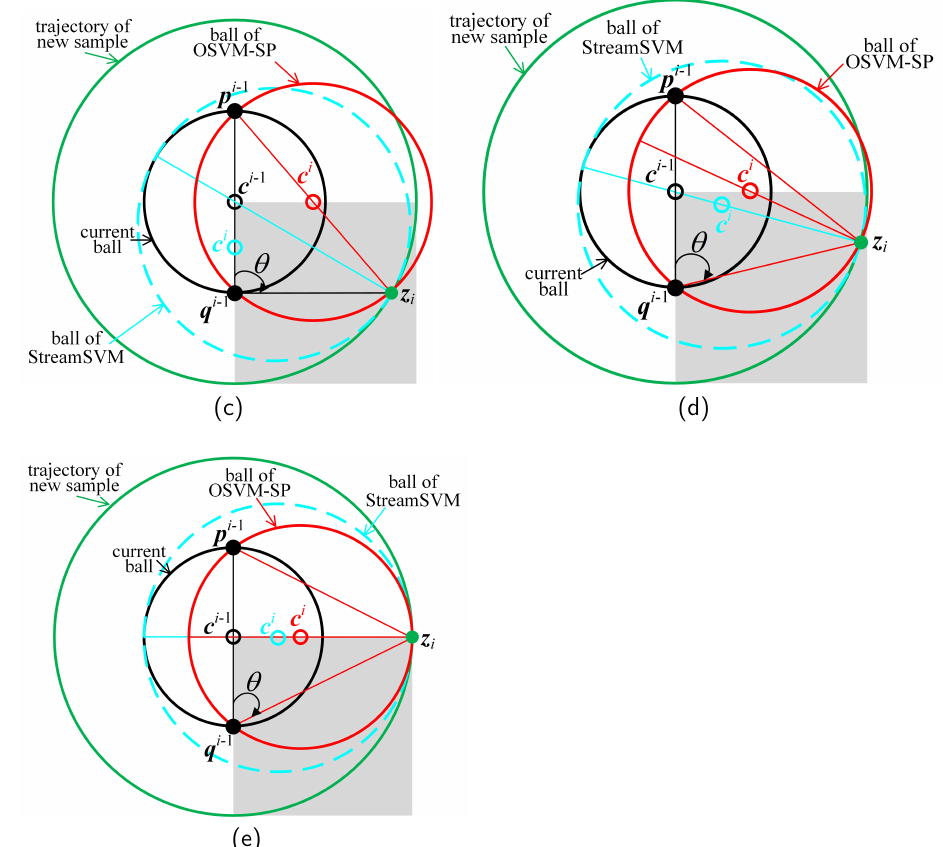
Figure 5. Comparison of OSVM-SP and StreamSVM in the MEB update [16] with respect to different values of θ . ( a ) θ = π ; ( b ) θ ∈ ( π /2, π ) ; ( c ) θ = π /2; ( d ) θ ∈ ( π /2, π /4 ) ; ( e ) θ = π